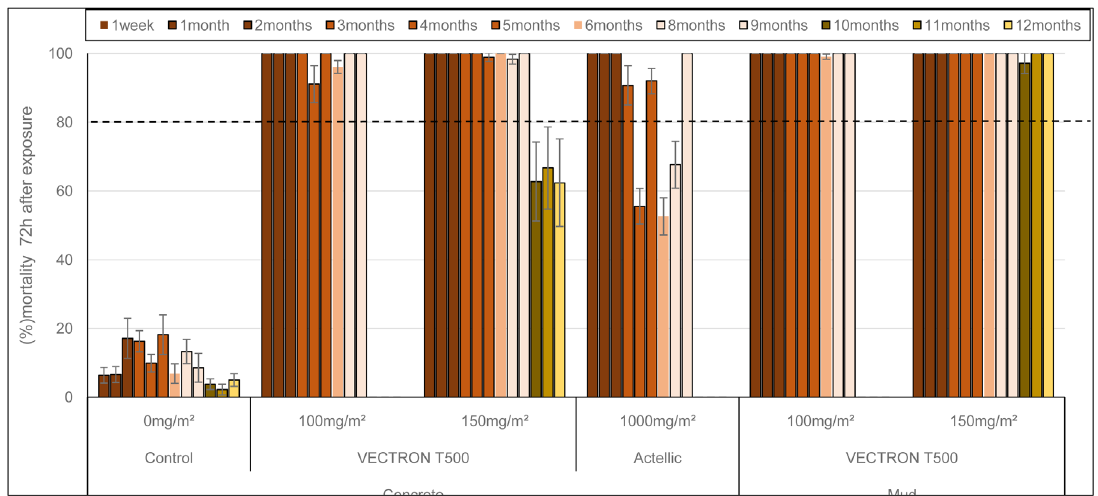
Figure 4. Mortality of Anopheles gambiae Kisumu strain exposed to treated huts surfaces in cone bioassays. Approximately 100 mosquitoes 2–5 days old were exposed for 30min to the hut walls and ceiling, and mortality recorded 72 hours after exposure. Overall, 10 cones per hut, two per side and 10 mosquitoes per cone were used at each time point. Each histogram represents the mean mortality rate of tested mosquitoes at each time point and error bars represent ± 95% confidence interval (CI). The dotted line represents World Health Organization (WHO) threshold.